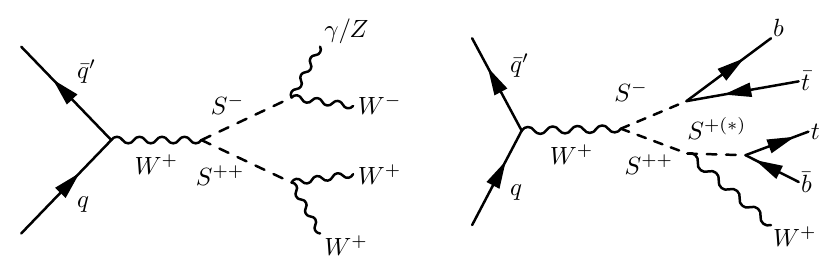
Figure 1. Examples of di-scalar channels from pair production via Drell-Yan processes with subsequent decays into SM